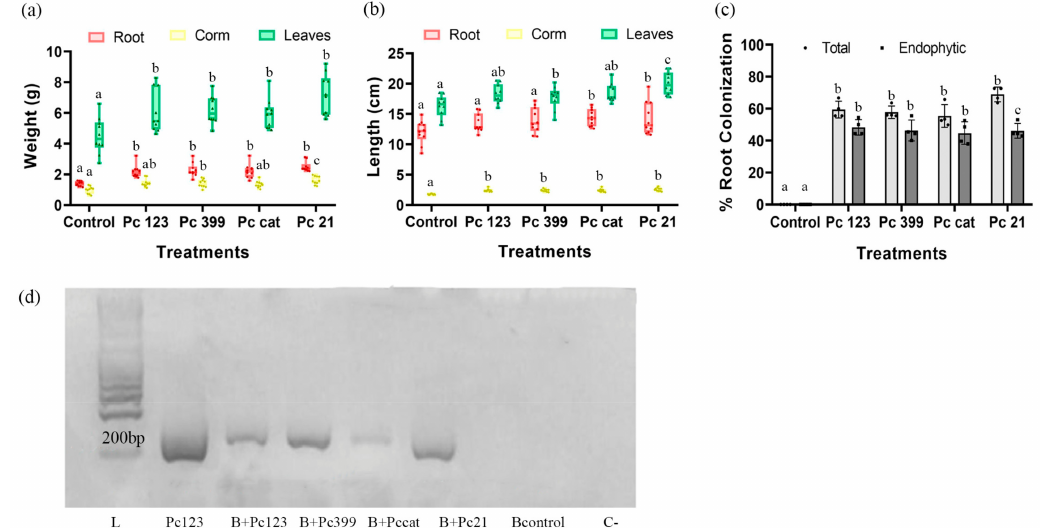
Figure 3. Effect of P. chlamydosporia diversity on the growth of 30-day-old plantlets. Treatments: inoculation of 5 × 10 4 conidia and chlamydospores suspension of each Pc strains (Pc123, Pc399, Pccat, and Pc21). ( a ) Root, corm, and leaf corm weight. ( b ) Fresh root, corm, and leaf length. ( c ) Total and endophytic root colonization. Growth indicators analyzed individually, the treatments with di ff erent letters show significant di ff erences ( p -value < α = 0.05), treatments without letters indicate there are no significant di ff erences. ( d ) Molecular detection of Pc strains colonizing M. acuminata roots, using the vpc1 gene. Abbreviations: L, ladder; B + Pc123, B + Pc399, B + Pc cat, B + Pc21, DNA extracted from 30 dpi roots